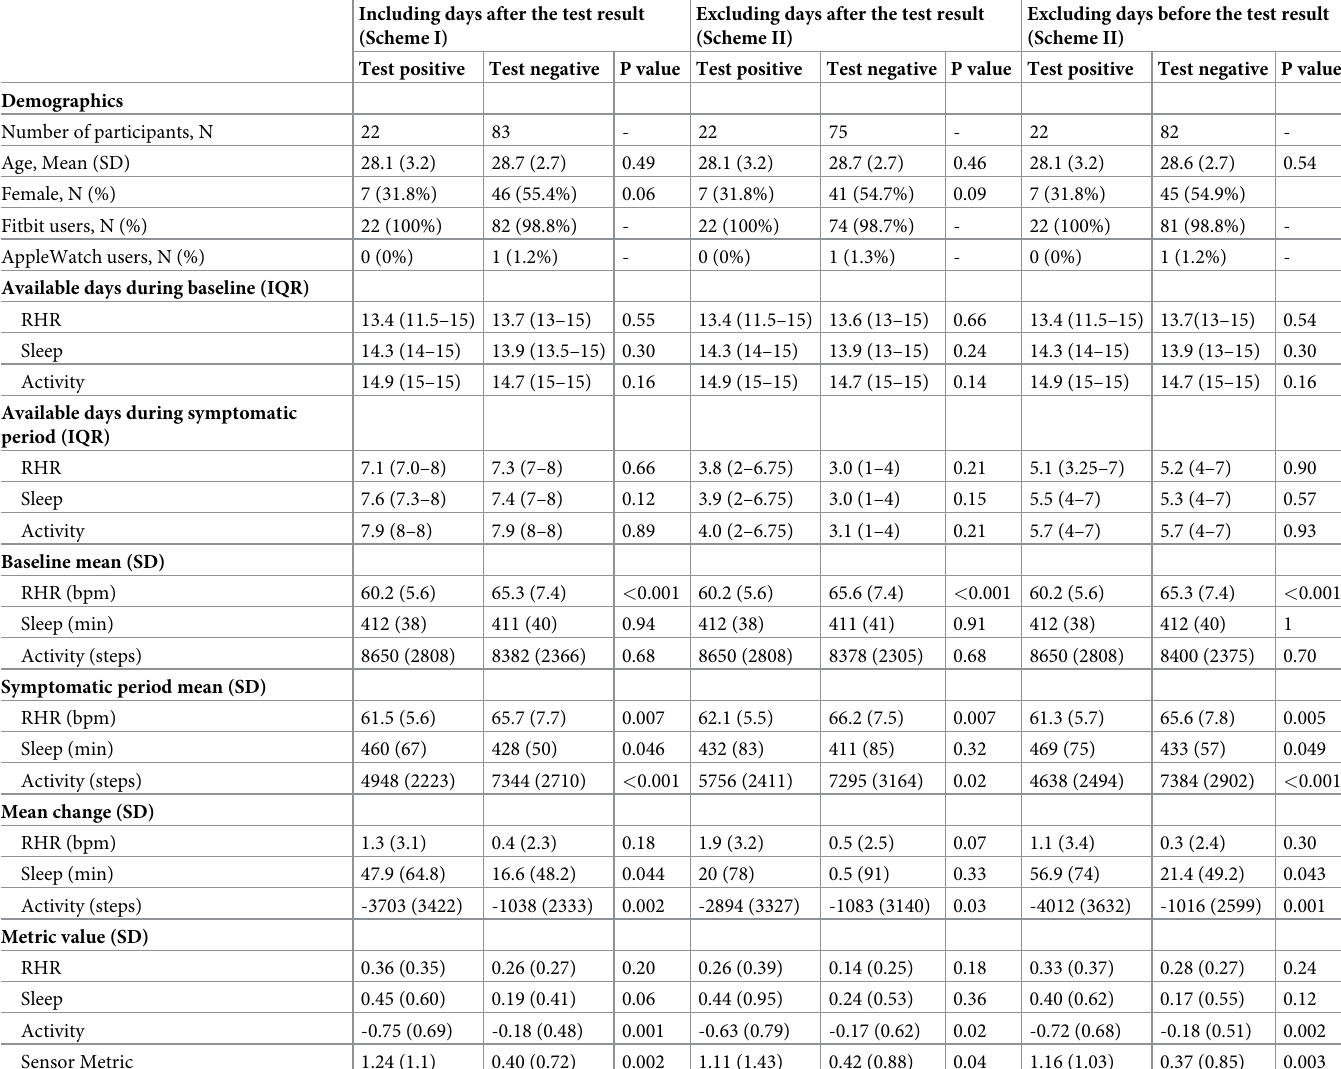
Table 1. Summary of key characteristics, metrics and COVID-19 test results among symptomatic participants. Including days after the test result (Scheme